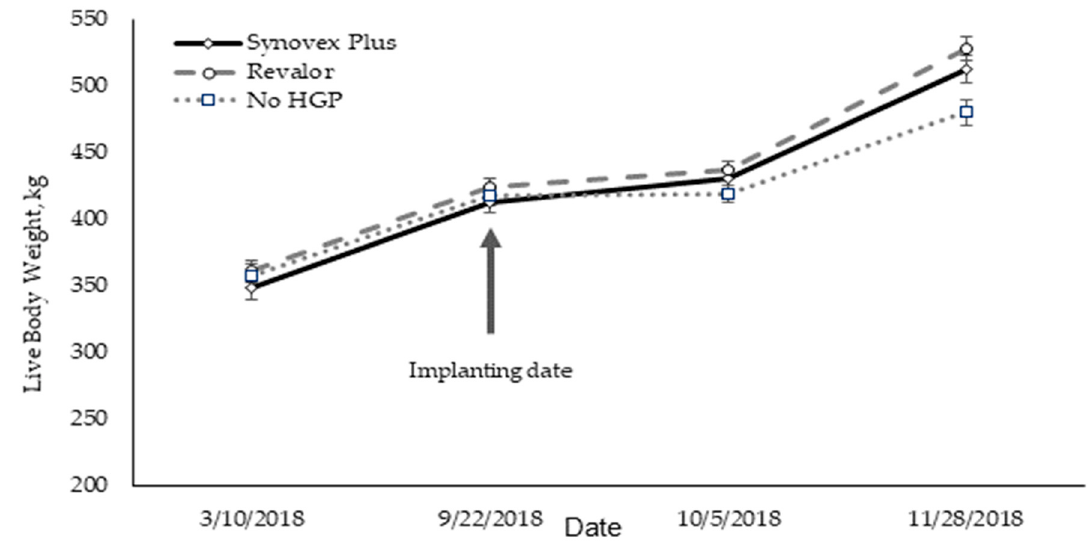
Figure 2. Evolution of body weight gain of steers during the study period (SEM) (HGP = hormonal growth promoting).